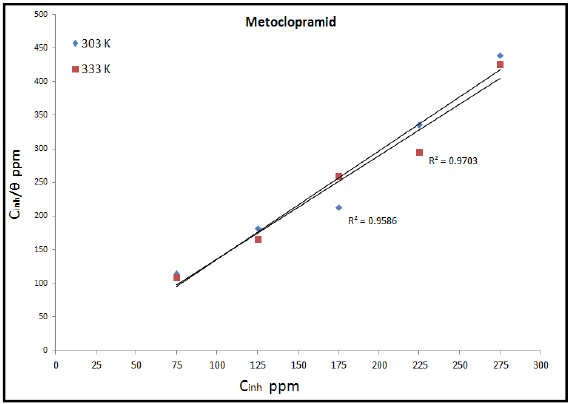
Fig. 4. Langmuir adsorption isotherm of expired drug on steel at two